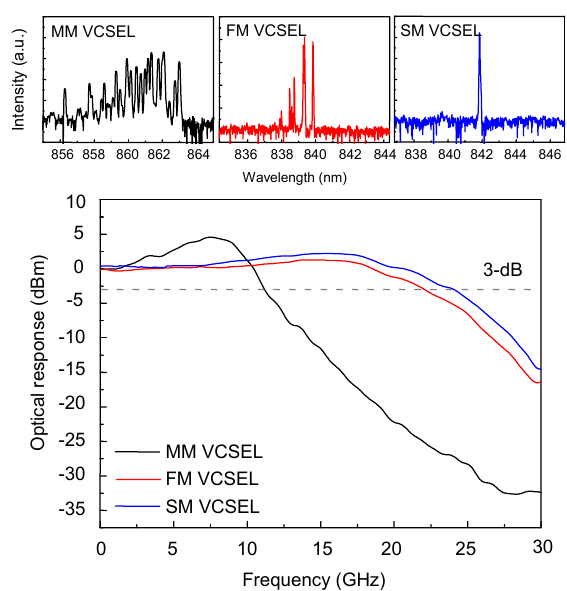
Fig. 8 | Optical spectra and frequency responses of the different- type VCSELs